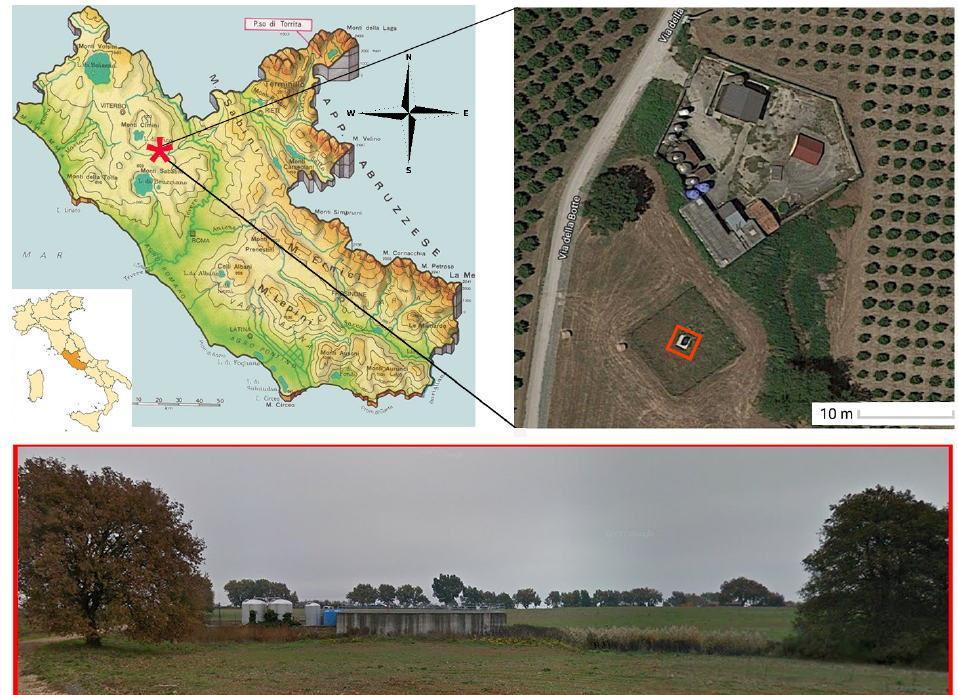
Figure 1. Varano waterwell location where water was collected for this study. A detailed map of the Lazio region is shown and the specific area is indicated by a star. The red rectangle on the enlarged image indicates Varano waterwell.